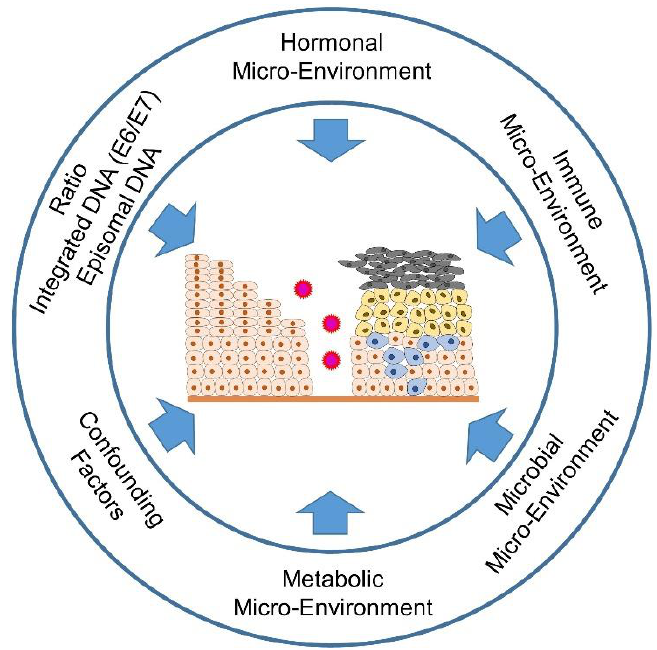
Figure 1. Important influences on cervical carcinogenesis.